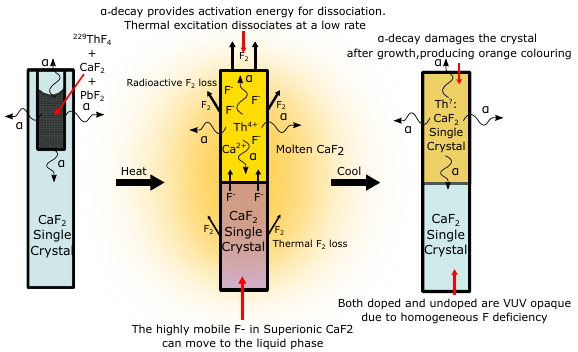
Figure 7. Schematic representation of the radioactively induced loss of fluoride during the growth process (compare to Fig. 1), taking the 1 MBq 229 Th crystal as an example (see Fig. 2). First the crystal is filled with the radioactive powder. During growth, a part of the crystal is molten and a part of the crystal is in the superionic state. In the liquid, the 229 Th is dissolved and the α -decay locally provides the energy to dissociate CaF 2 , − producing F 2 that is pumped away. The superionic crystal has extremely mobile F atoms which will diffuse to − the liquid phase, supplying it with more F . The resulting crystal will have a homogeneous deficiency of F due to its high mobility during growth, but only a partial doping of Th due to its low mobility during growth. As is shown in “Methods”, only a small fraction of the Th penetrates the unmolten